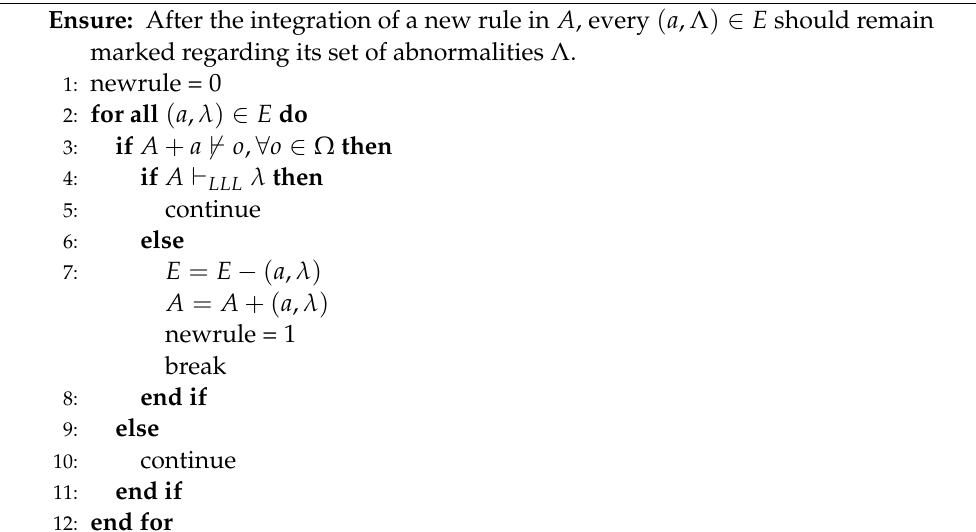
Algorithm 3: RulesUnmarking